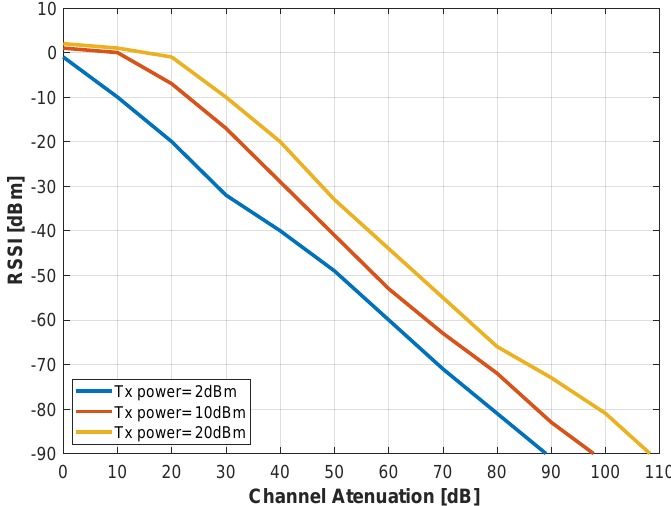
Figure 13. Experimental LoPy4 RSSI